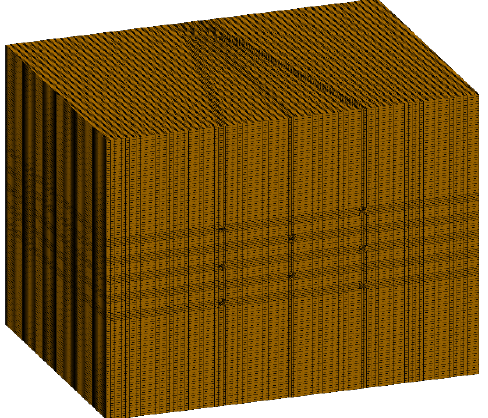
Figure 5. Meshing of the rock model.